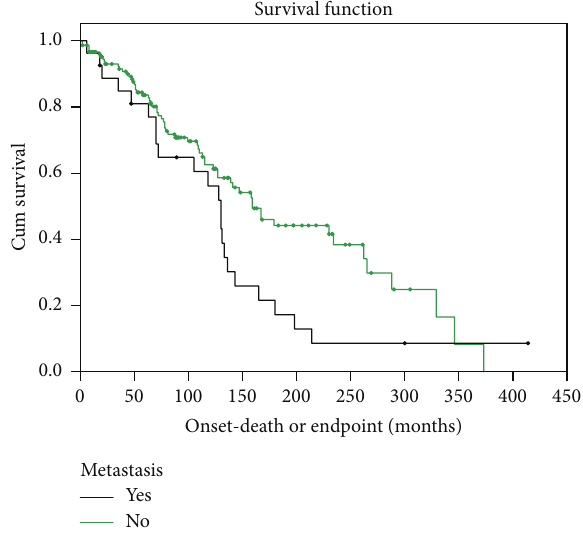
Figure 1: Survival distribution stratified by presence of metastatic disease. Diamonds represent censored data points.